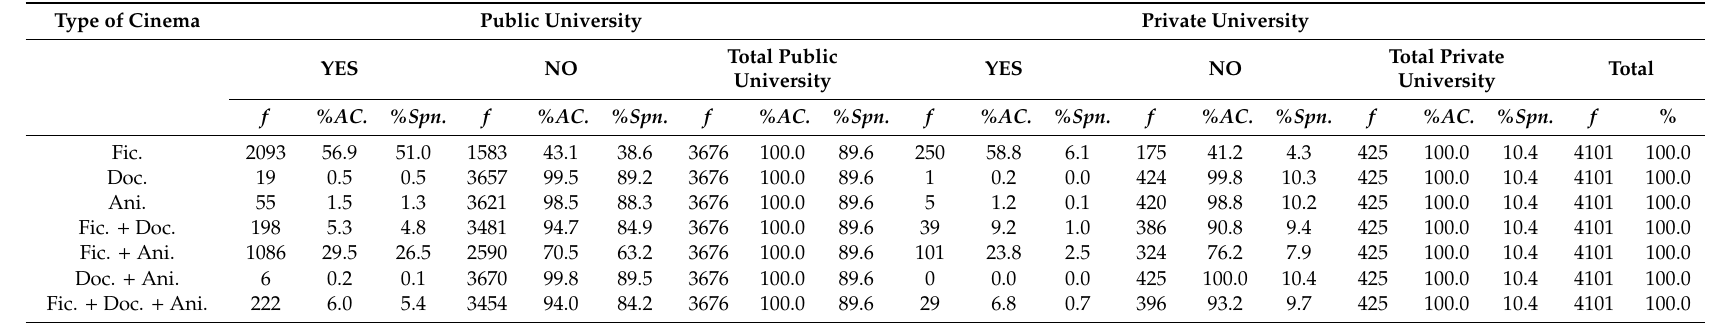
Table 13. Percentages and frequencies of the type of cinema viewed by the teacher (cid:48) s degree students, according to type of university. Type of Cinema